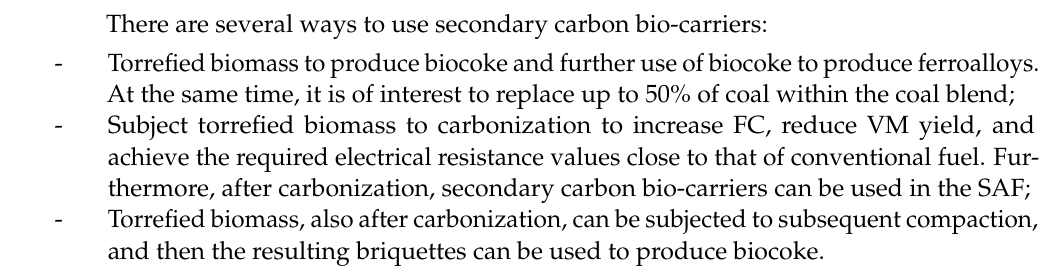
Figure 10. Main pathway for using secondary carbon bio-carriers in ferroalloy